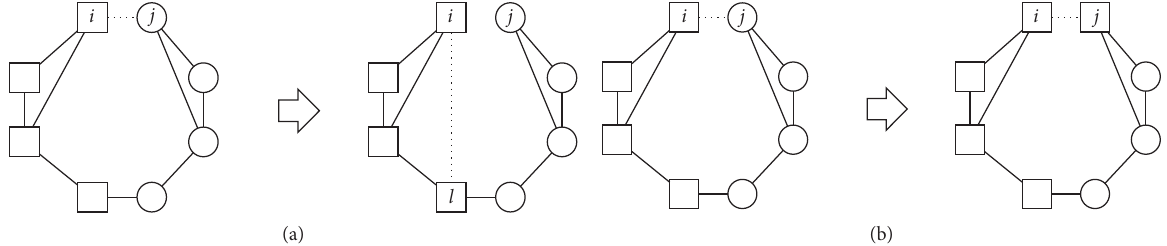
Figure 1: An illustration of the Holme model, with node shapes representing states. At each time step, the system is updated according to the process illustrated in (a) with probability ξ or (b) with probability 1 − ξ . In (a), a node i is selected at random and one of its links (in this case the link ( i , j )) is rewired to a new node l holding the same state as i . In (b), node i affects one of its neighbor j and makes j adopt the state of